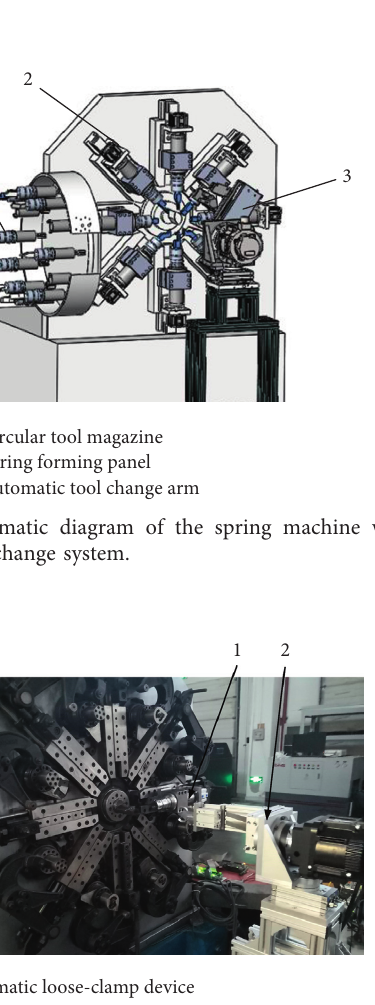
Figure 10: Physical prototype